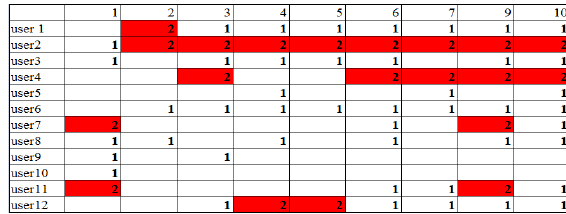
Figure 8: Table showing the cluster assignment of the user trajec- tories corresponding to tasks: 1,2,3,4,5,6,7,9 and 10. Task 8 has been removed as the quantity of data was insufficient. Outliers are highlighted in red mouse movements, was then applied to each of these clusters to determine similarity within the